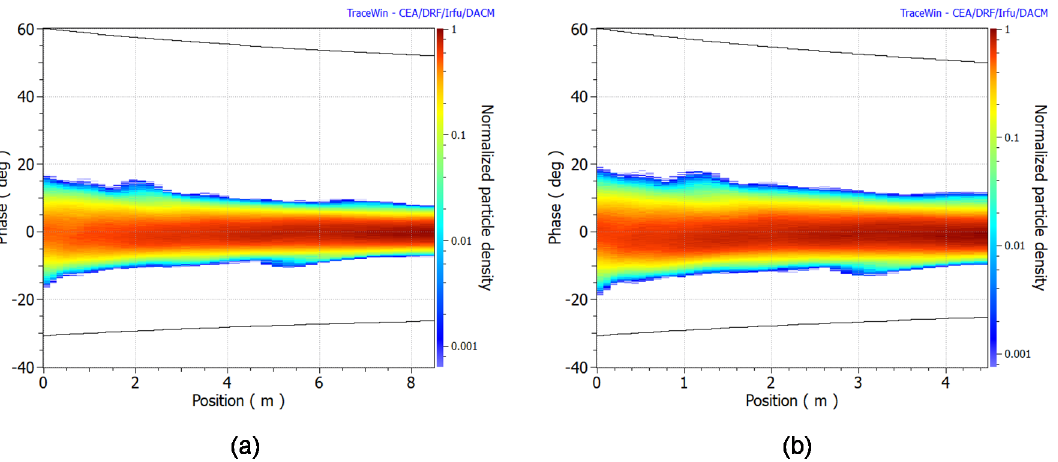
Figure 9. Simulated longitudinal beam envelopes inside the DTL cavities: ( a ) 162.5 MHz design, ( b ) 325 MHz design.